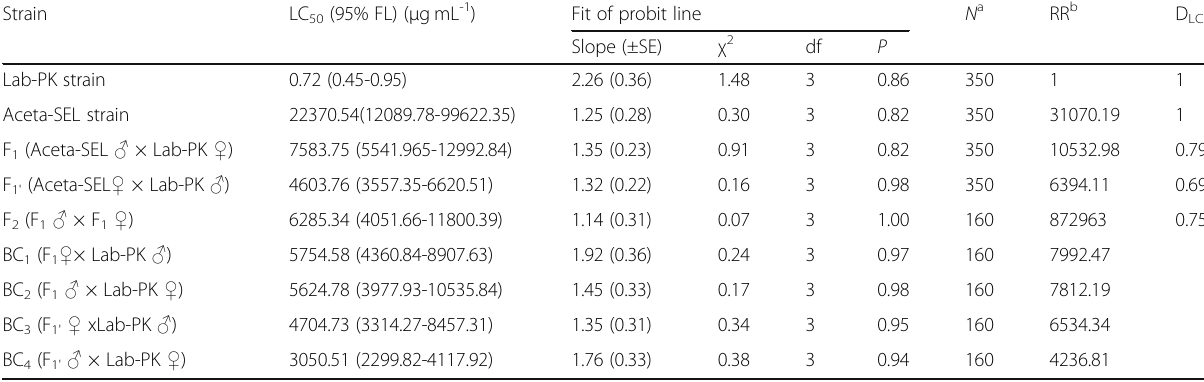
Table 2 Response of Lab-PK, resistant, reciprocal crosses and backcross strains of Chrysoperla carnea to acetamiprid Strain